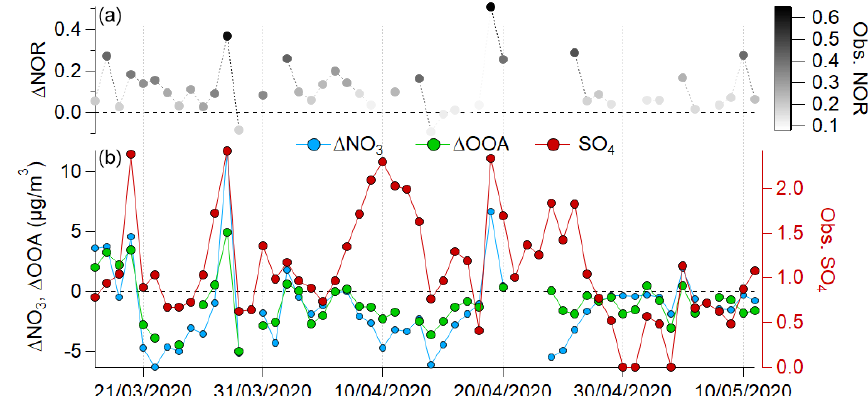
Figure 9. Temporal variation during LP2020 of (b) (cid:49) NO 3 , (cid:49) OOA and SO 4 concentrations (µg/m 3 ) and (a) (cid:49) NOR values, color-coded by observed